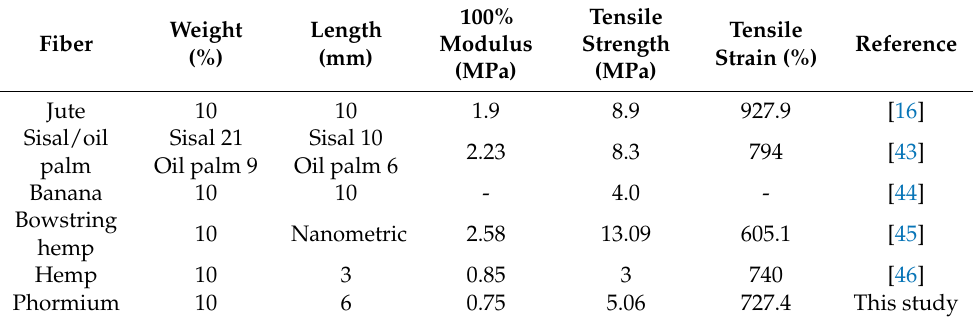
Table 4. Comparison between some tensile results of this and other